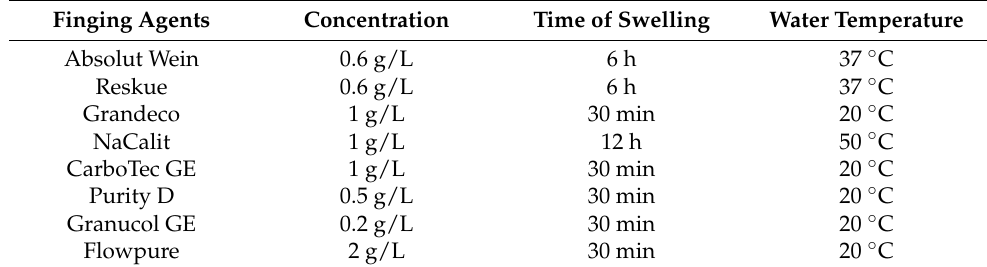
Table 3. Fining conditions of the used